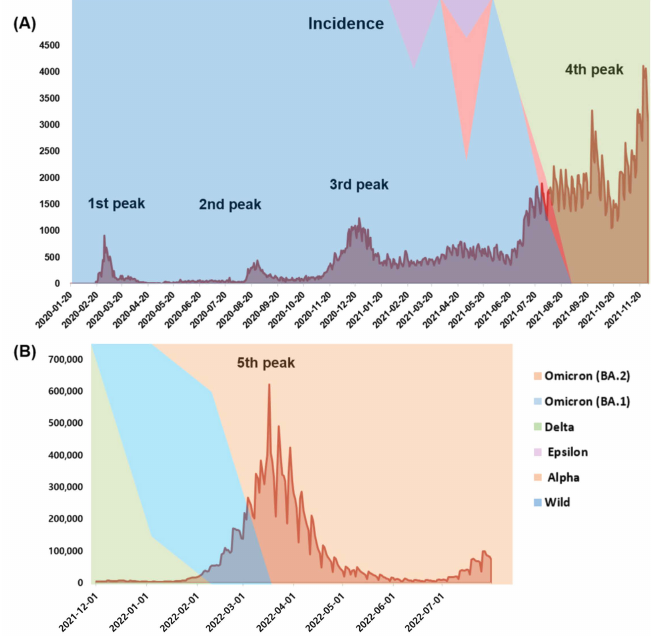
Figure 1. Distribution of newly confirmed cases of SARS-CoV-2 with five surge peaks in South Korea ( A ) from January 2020 to November 2021 and ( B ) from December 2021 to July 2022. Data from the Korean Center for Disease Control (https://ncov.kdca.go.kr/, accessed on 2 January